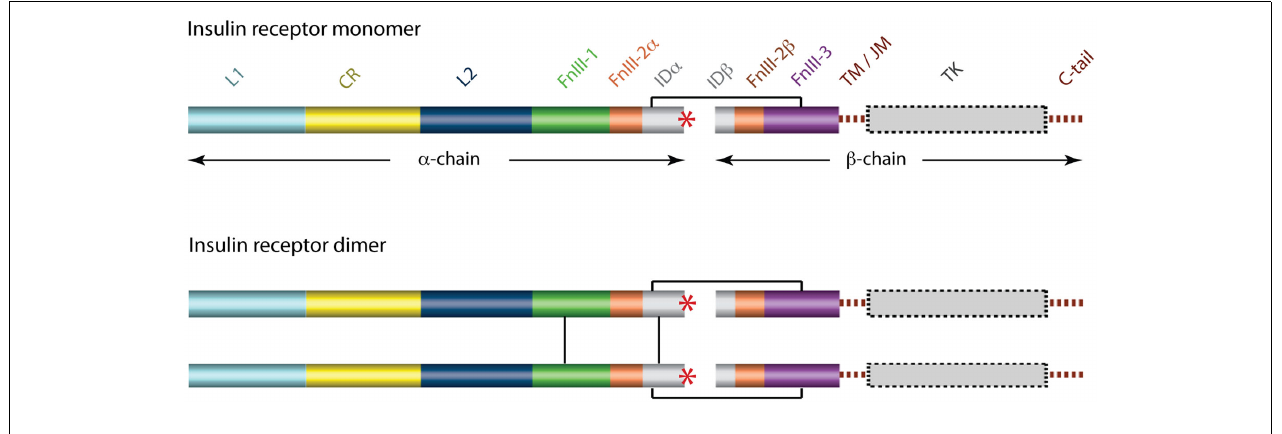
domain span both the α - and the β -chains of the mature protein.The critical C-terminal segment of the α -chain ( α CT) is indicated by a red asterisk. Inter-chain and inter-monomer disulfide bonds are indicated by black line segments and membrane and cytoplasmic regions are shown in dashed